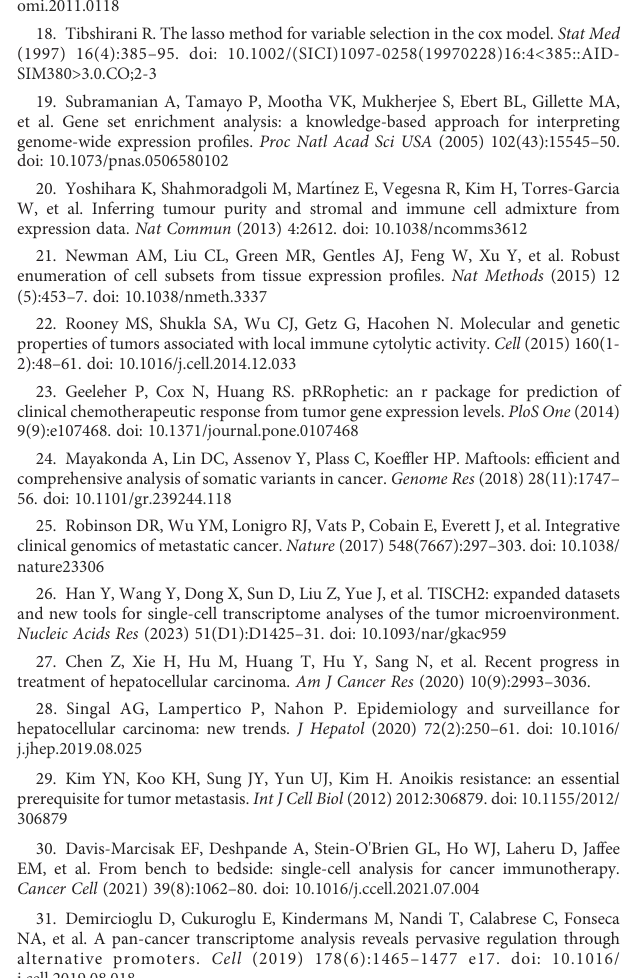
SUPPLEMENTARY FIGURE 1 The risk model performance. (A) Kaplan – Meier curves for OS in TCGA testing cohort. (B) Kaplan – Meier curves for OS in GSE14520 cohort. (C) Time-